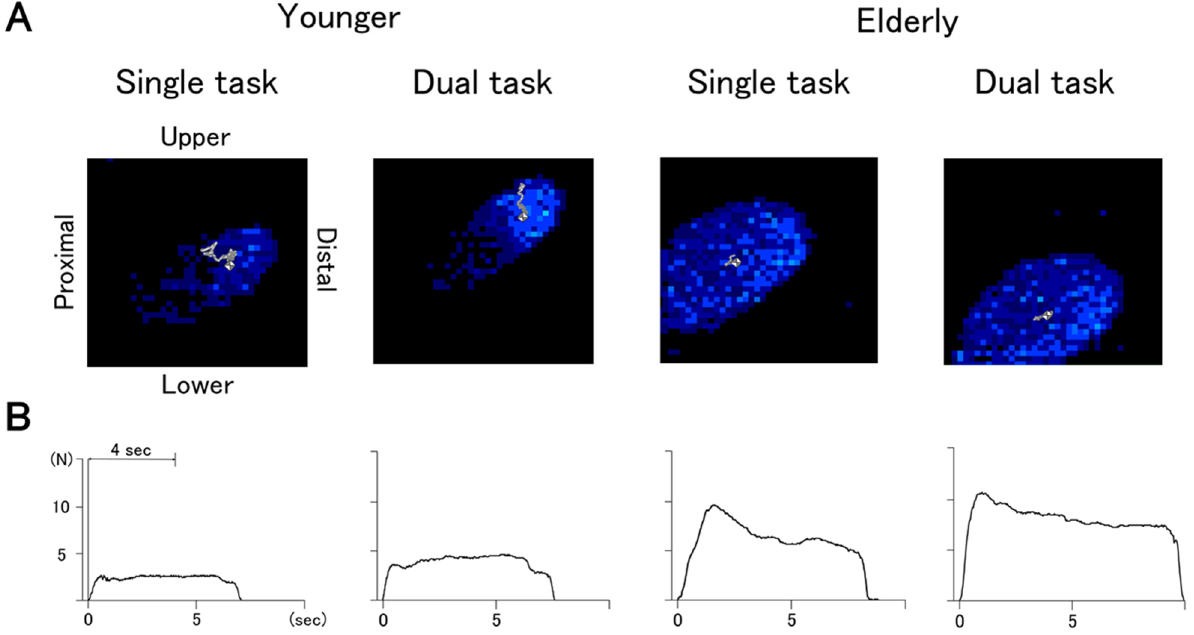
Table 1. Comparison between the older and younger adults.